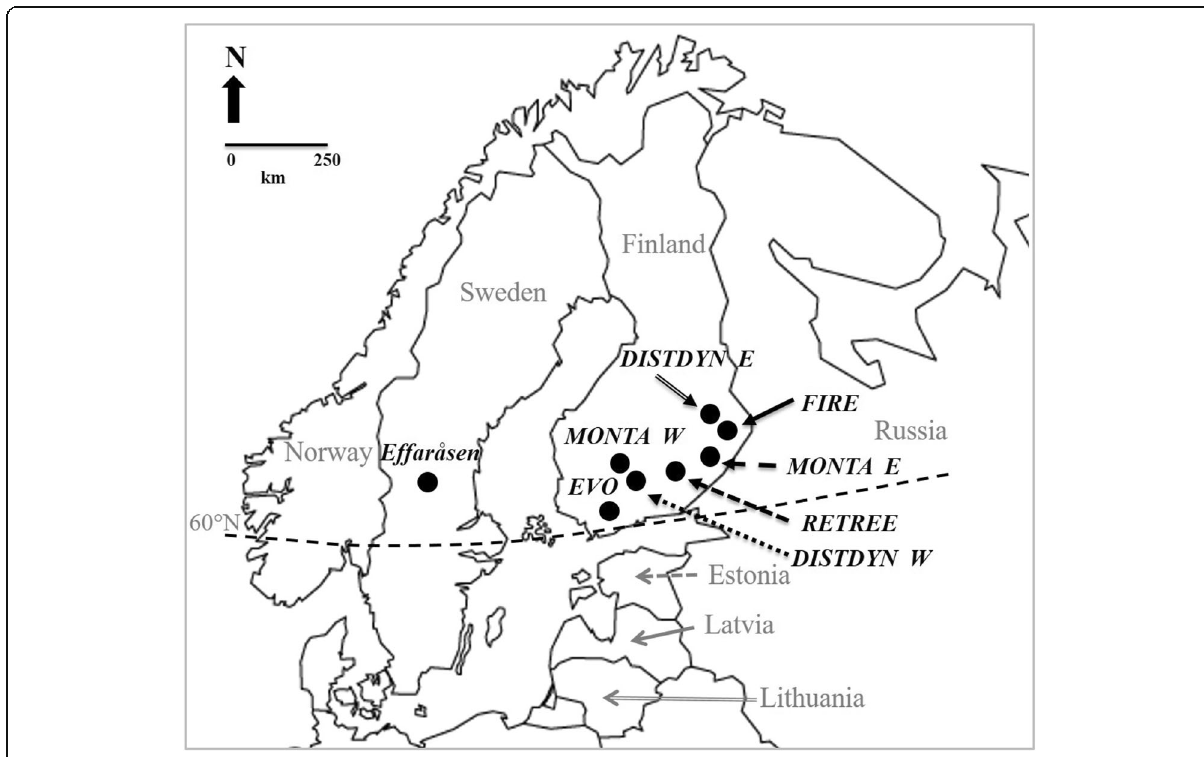
Fig 2 Location of the retention experiments in Finland and Sweden, Northern Europe. For further information, see Table 2. Country names are given in gray, experiment names in black. Line types for countries: Lithuania double, Latvia solid, Estonia dashed. Line types for experiments: DISTDYN W dashed (short), RETREE dashed (longer), MONTA E dashed (longest), FIRE solid, DISTDYN E